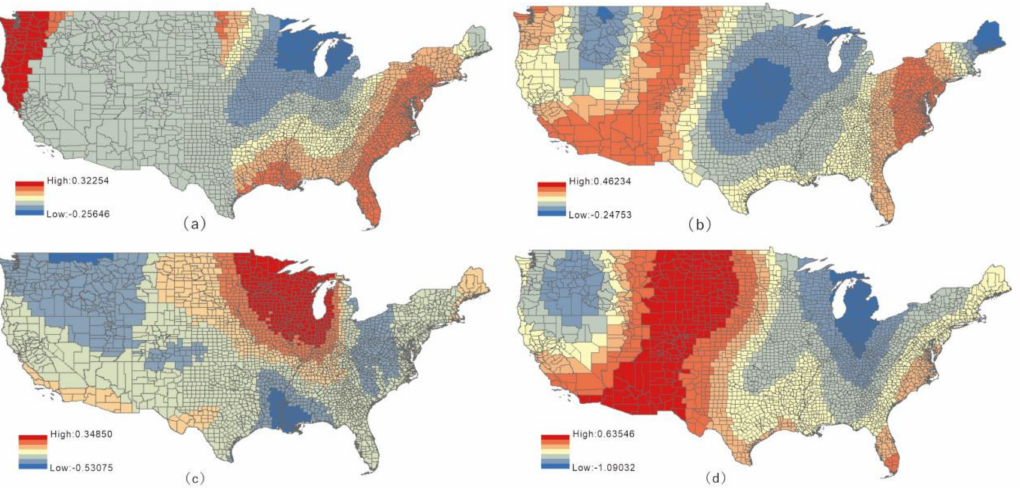
Figure 1. GWR coefficients map. ( a ) Socioeconomic status subindex and infection rate. ( b ) Household characteristics and disability subindex and infection rate. ( c ) Racial/ethnic minority status and lan- guage subindex and infection rate. ( d ) Housing type and transportation subindex and infection